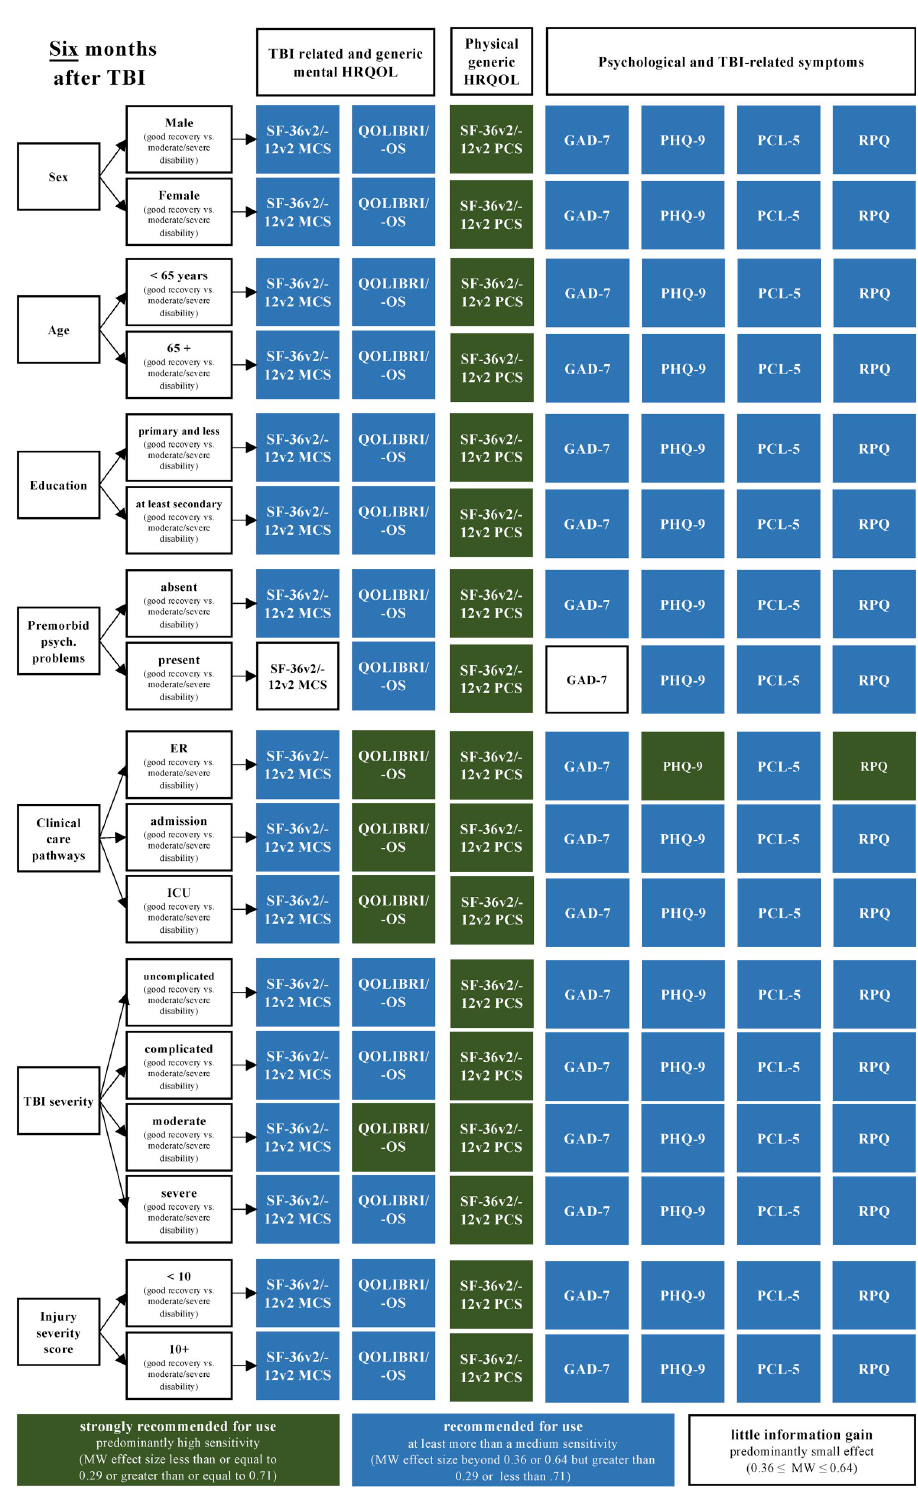
PLOS ONE | https://doi.org/10.1371/journal.pone.0280796 April 7,